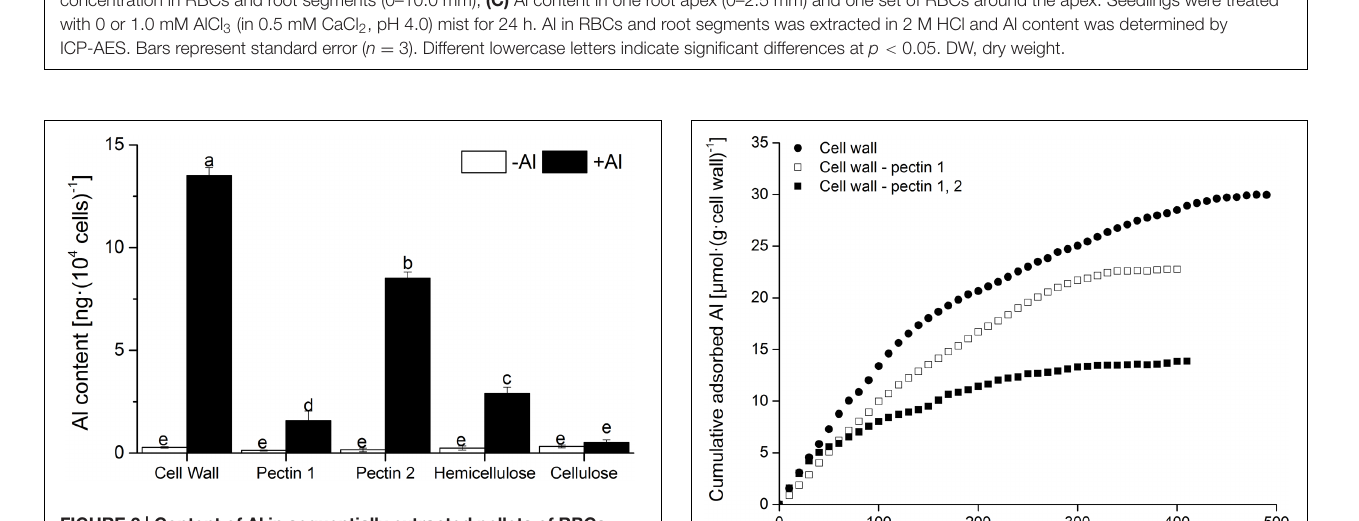
FIGURE 2 | Content of Al in sequentially extracted pellets of RBCs. Seedlings were treated with 0 or 1.0 mM AlCl 3 (in 0.5 mM CaCl 2 , pH 4.0) mist for 24 h. Al in pellets of RBCs was extracted in 2 M HCl and determined by ICP-AES. Bars represent standard error ( n = 3). Different lowercase letters indicate significant differences at p < 0.05.